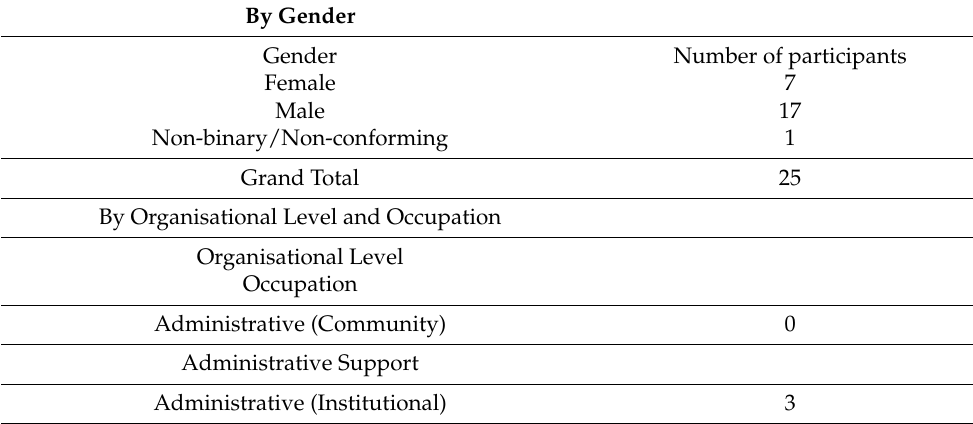
Table 1. Participants’